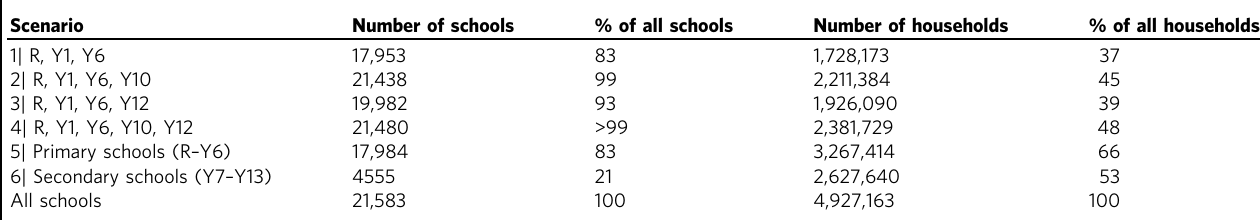
Table 1 The number of schools open and households with children attending school in each school reopening scenario.